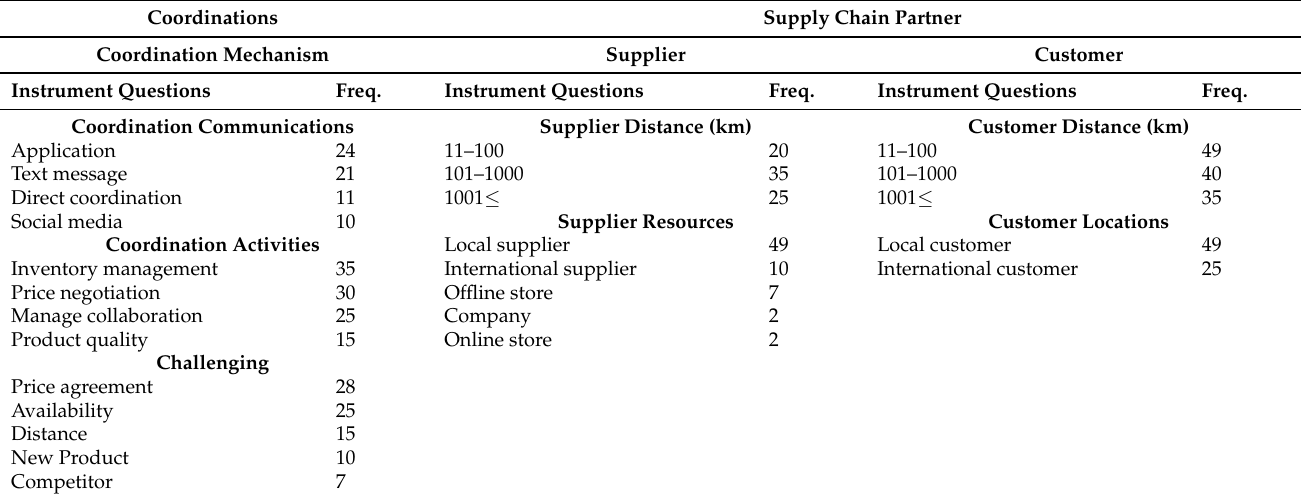
Table 5. Data collected from the correspondents based on the supply chain network